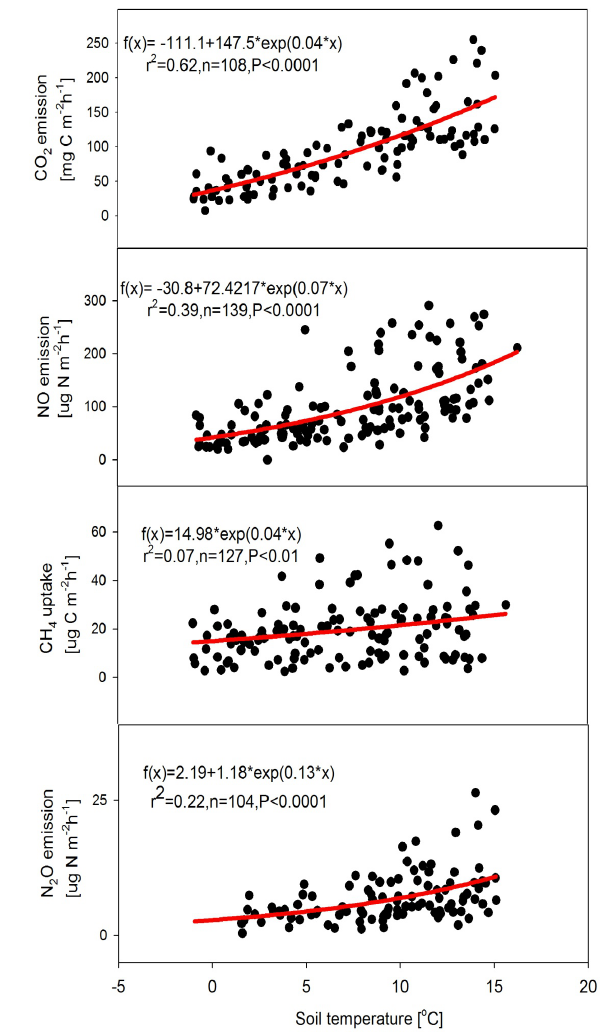
Fig. 5. Dependency of soil trace gas emissions on soil tempera- ture (in 5cm soil depth for CO 2 and N 2 O, in 10cm soil depth for Figure 5. Dependency of soil trace gas emissions on soil temperature (in 5 cm soil depth for 2 NO, and in 15cm soil depth for CH 4 ). For this analysis monthly CO 2 and N 2 O, in 10cm soil depth for NO, and in 15cm soil depth for CH 4 ). For this analysis 3 mean values as obtained for the period 1994–2010 were used. N 2 O: freeze-thaw periods were excluded. monthly mean values as obtained for the period 1994-2010 were used. 4